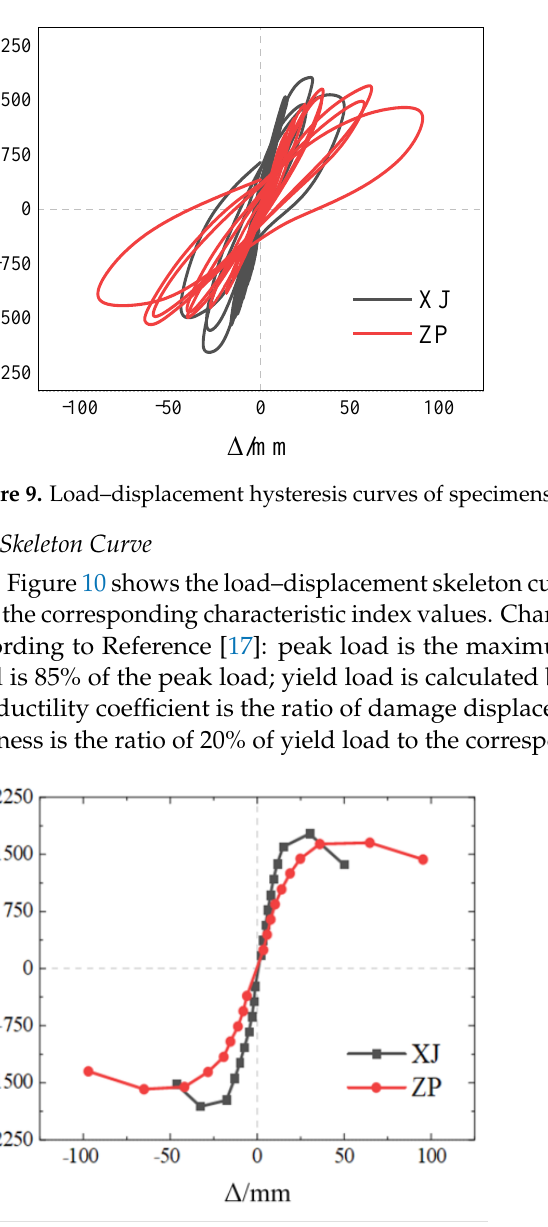
Figure 10. Load–displacement skeleton curves of specimens XJ and ZP. Table 3. Characteristic index values in the load–displacement skeleton curves of specimens XJ and ZP. Figure 10 and Table 3 illustrate that: the load–displacement skeleton curves of each specimen have distinct elastic, elastoplastic, and decreasing sections. The skeleton curve of ZP was below that of XJ in both elastic and inelastic rising sections; yield load, ultimate load, failure load, and initial stiffness were 9%, 6%, 6%, and 23% less, respectively. However, the inelastic decreasing section of ZP was significantly above XJ and decreased slowly; the ductility ratio was 22% greater than that of XJ. This was due to the elastic modulus of the grout being less than that of the concrete. Voids might also have been